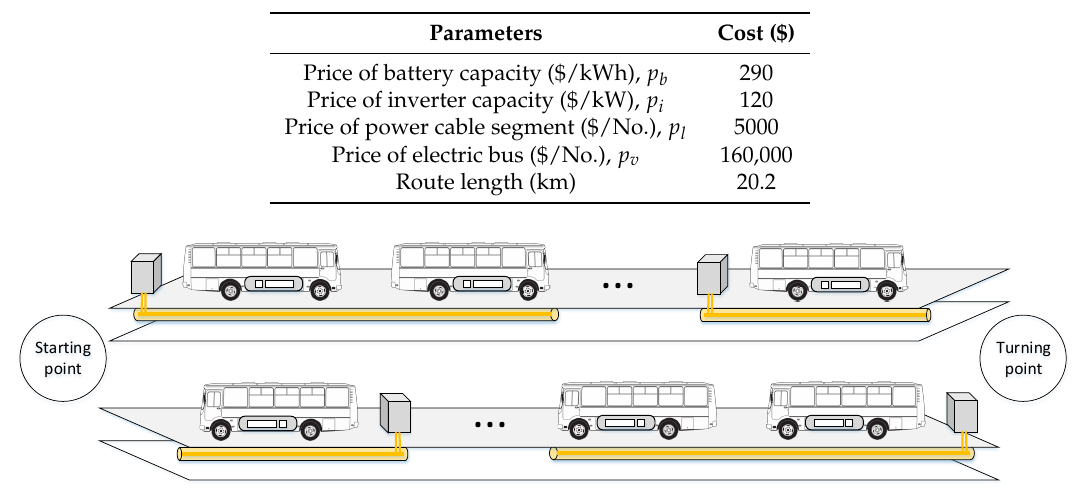
Table 2. Parameters of the simulation environment.